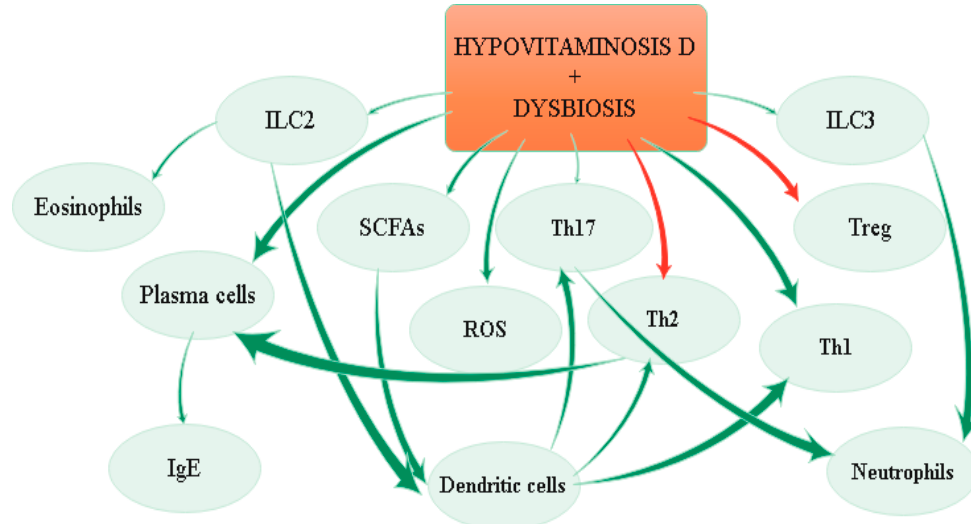
Figure 3. Effects of hypovitaminosis D and dysbiosis on the immune system.